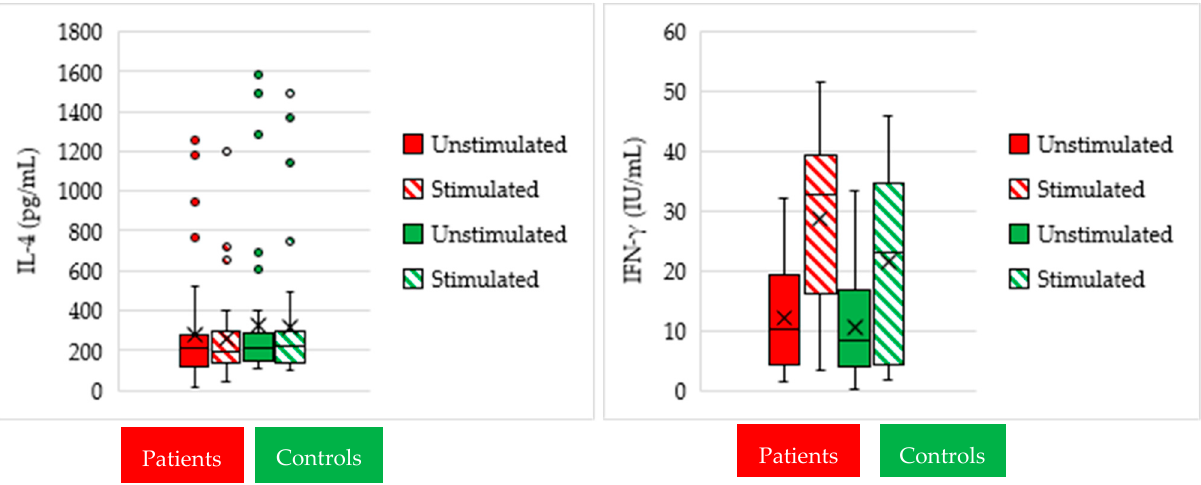
Figure 1. Boxplots showing the analysis of IL-4 (pg/mL) and IFN- γ (IU/mL) measurements (median and quartile range) in unstimulated and stimulated cultures in patient and control groups.